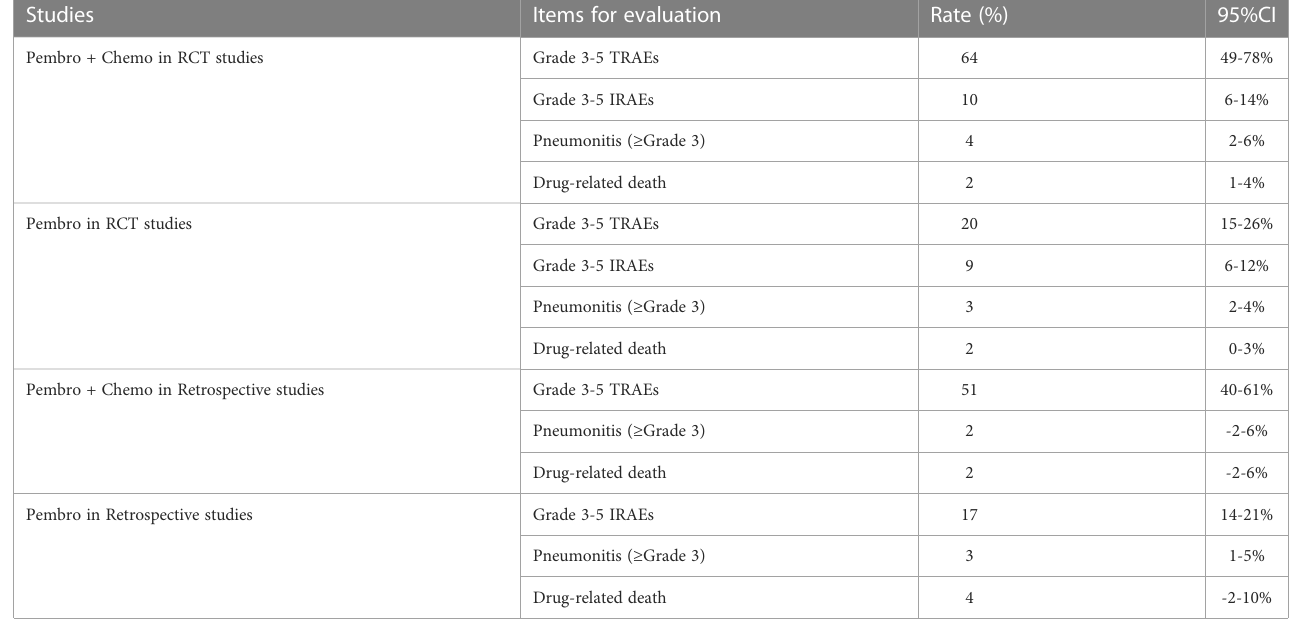
TABLE 5 Meta-analysis of the rate of SAEs, pneumonitis, and drug-related death in combination therapy.